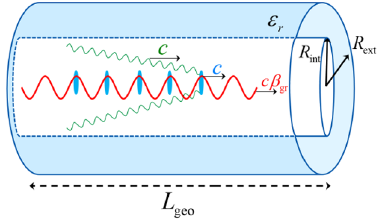
FIG. 1. Schematics of the basic principle and envisaged geometry. Five relativistic microbunches (blue) are accelerated by TM 01 laser mode (red) which propagates at c β velocity, in a vacuum channel of a dielectric loaded cylinder. The wake (green), generated by the bunches, propagates at their velocity [28].